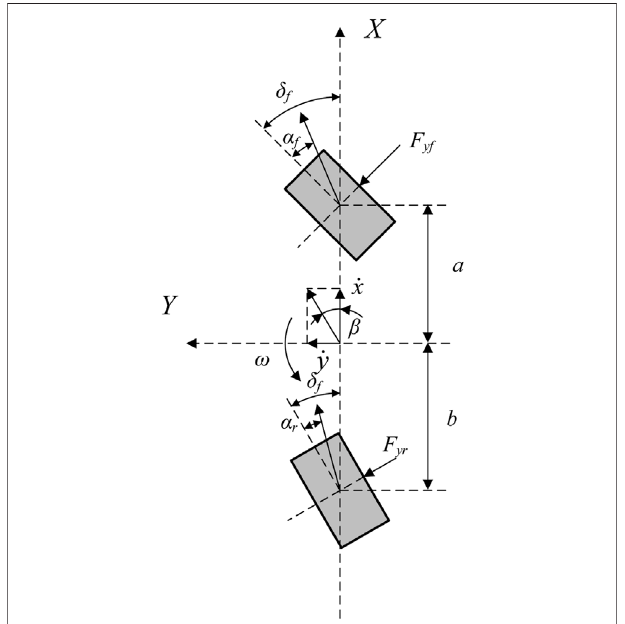
FIGURE 1 | Two-degrees-of freedom vehicle model.